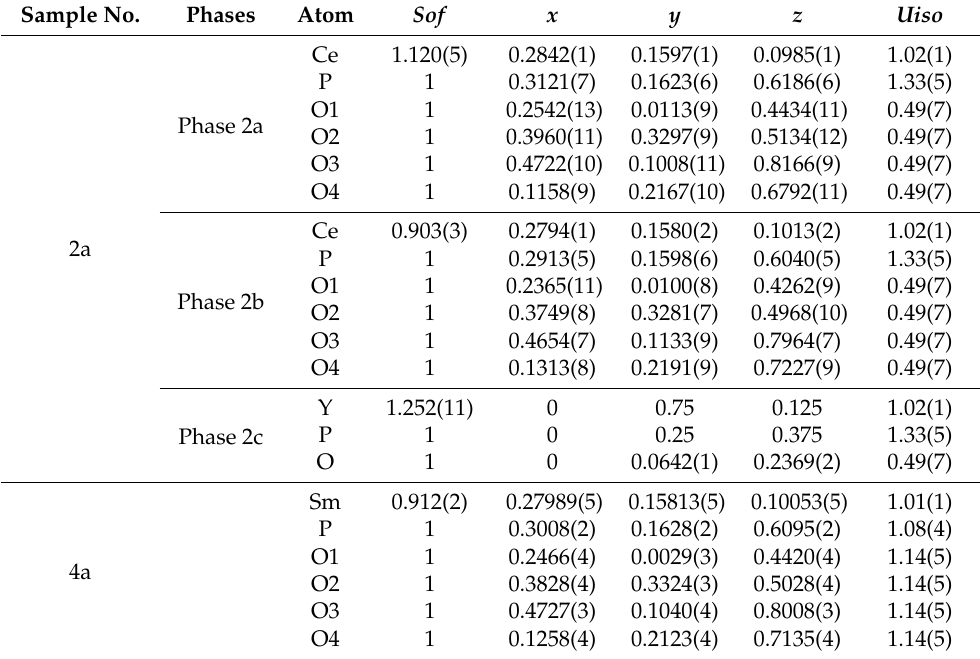
Table 7. Atom positions, isotropic displacement parameters, and site occupancy factors ( sofs ) for samples 2a and 4a.